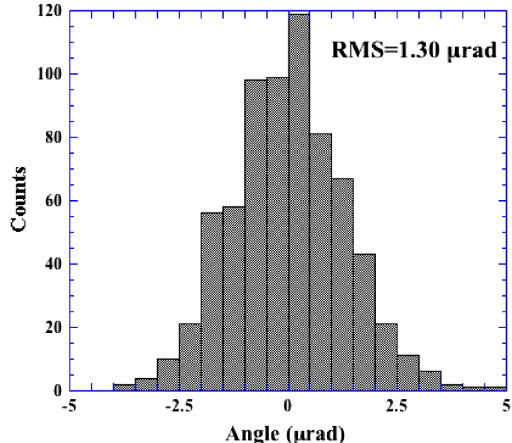
FIG. 12. The kick angle jitter distribution: Fit from the mea- sured horizontal positions using 19 BPMs and the R12 of the design transfer matrix at each location estimates the angle distribution of the kicker.